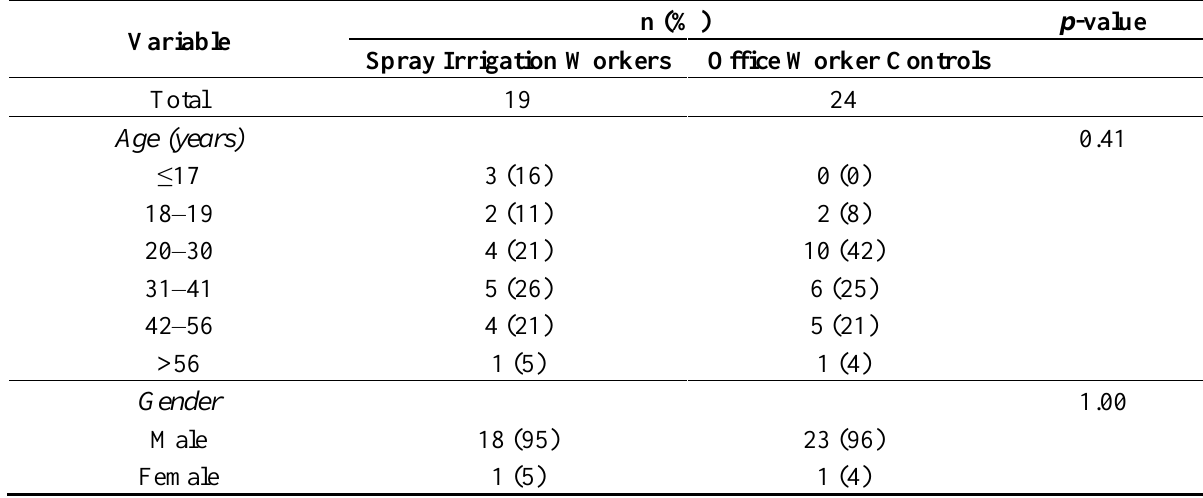
Table 1. Comparison of participant characteristics between spray irrigation workers and office worker controls a